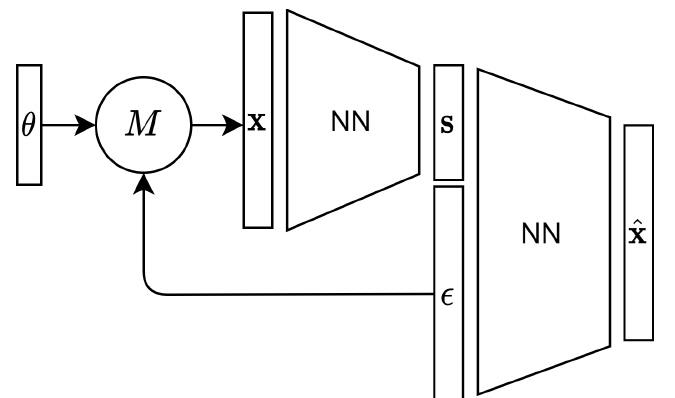
Figure 1: Basic ENCA architecture: The stochastic model needs to be available in the form of a deterministic function, M , of a parameter vector θθθ and a (bare) noise realization εεε . The encoder is trained on model realizations x , and produces summary statistics s ( x ) . The decoder is trained to reproduce the model realizations ˆ x ( s , εεε ) , based on s and the same noise realizations that have been used by M . Layers within encoder and decoder neural network (NN) blocks can be optimized based on the prior knowledge about M